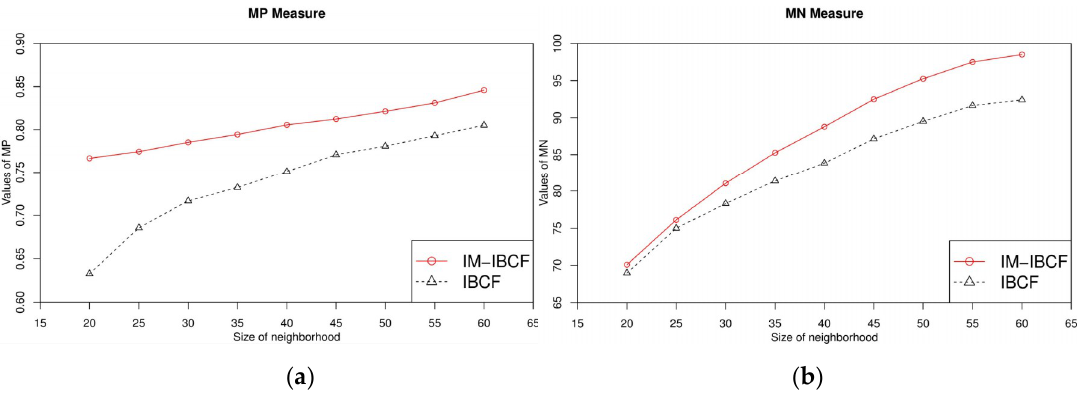
Figure 3. MP ( a ) and MN ( b ) results with MovieLens 1M dataset.